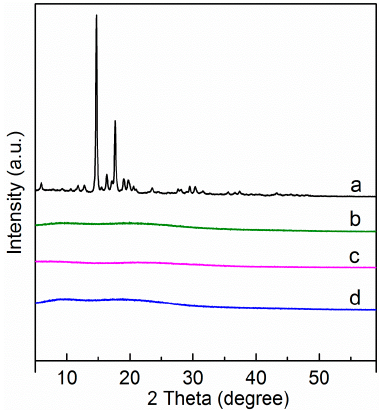
Figure 4. XRD patterns of the raw hydrocortisone drug ( a ); and the hydrocortisone-loaded microparticles obtained at a drying temperature of 155 °C with an ethanol/water solvent of 1:4 ( b ); 1:1 ( c ); and 4:1 ( d ) volume ratio, respectively.